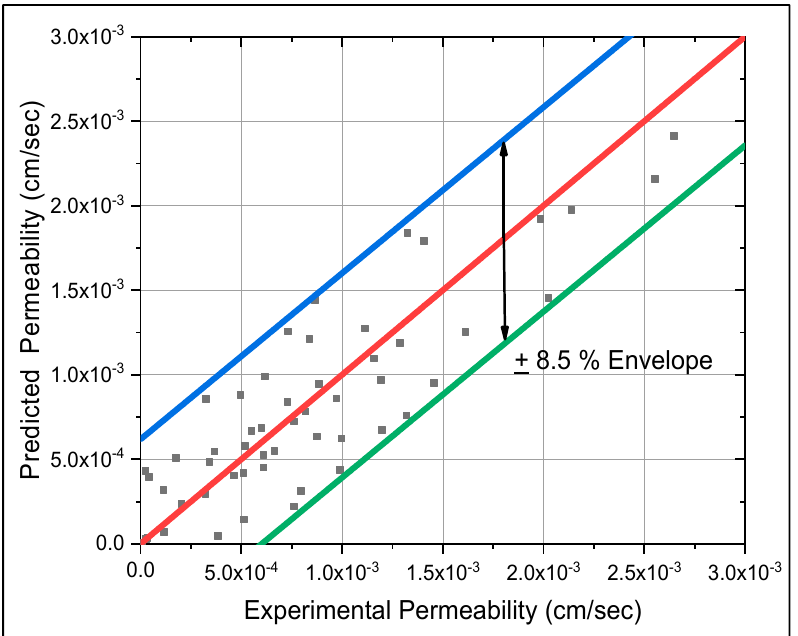
Figure 9. Predicted permeability versus experimental permeability.